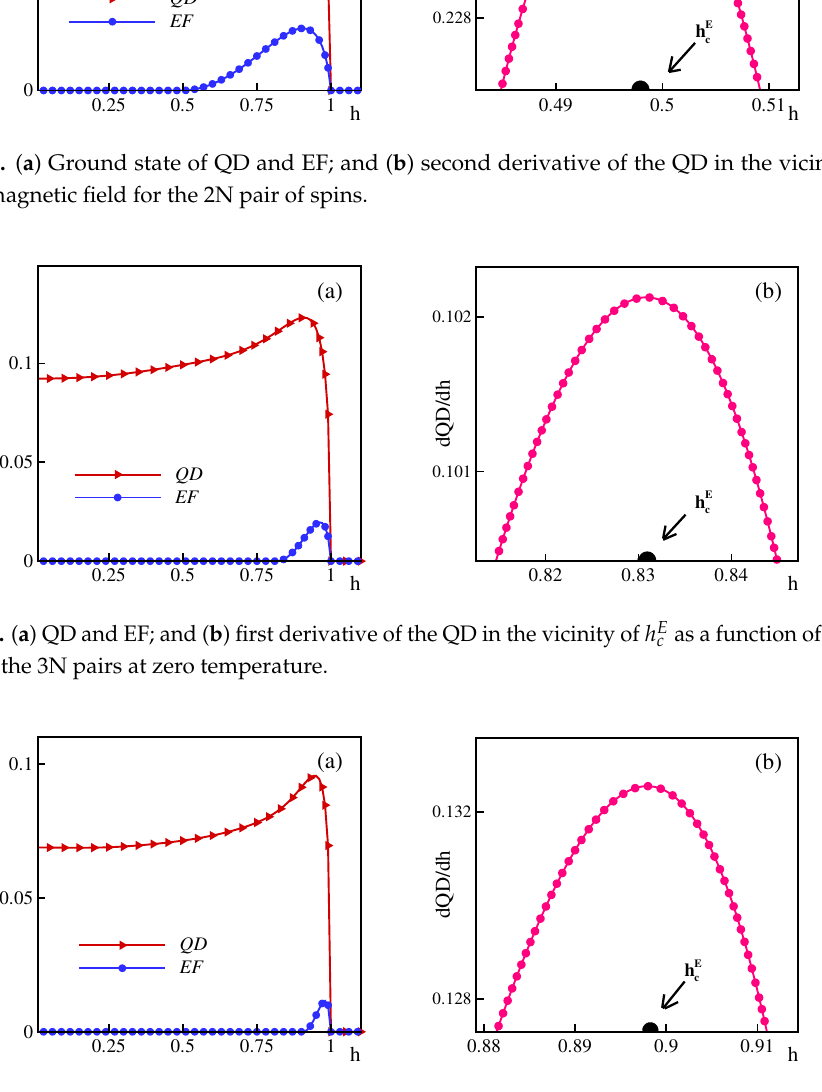
Figure 4. ( a ) Magnetic field dependence of QD and EF; and ( b ) first derivative of the QD in the vicinity of h E c for the 4N spin pairs at zero